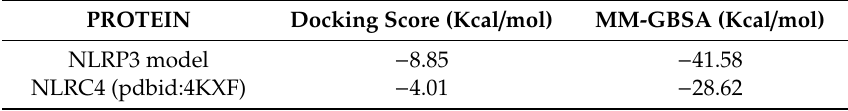
Table 1. Comparison between NLRP3 and NLRC4 binding evaluation.